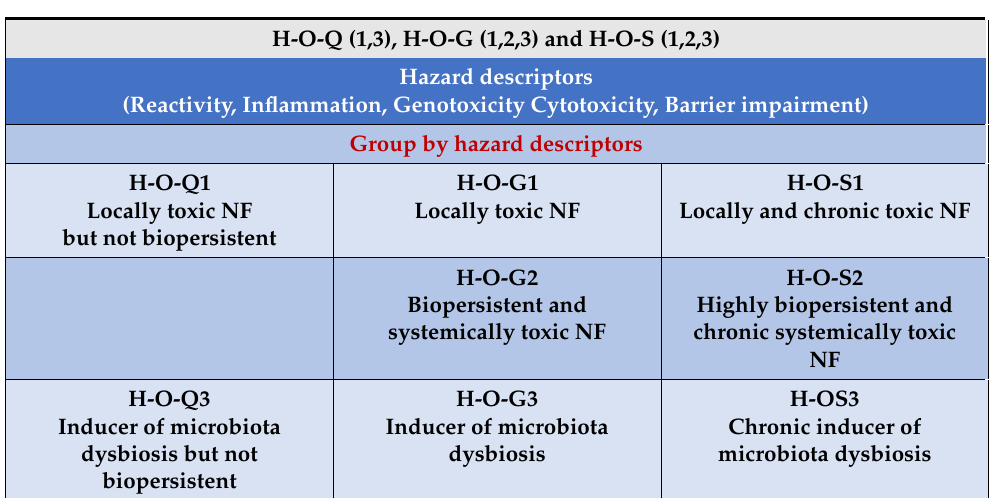
Table 3. Hazard based groups of NFs generated by means of similarity assessment (for the case of H-O-Q and H-O-G) or toxicity assessment (for the case of H-O-S) via oral human hypotheses and related